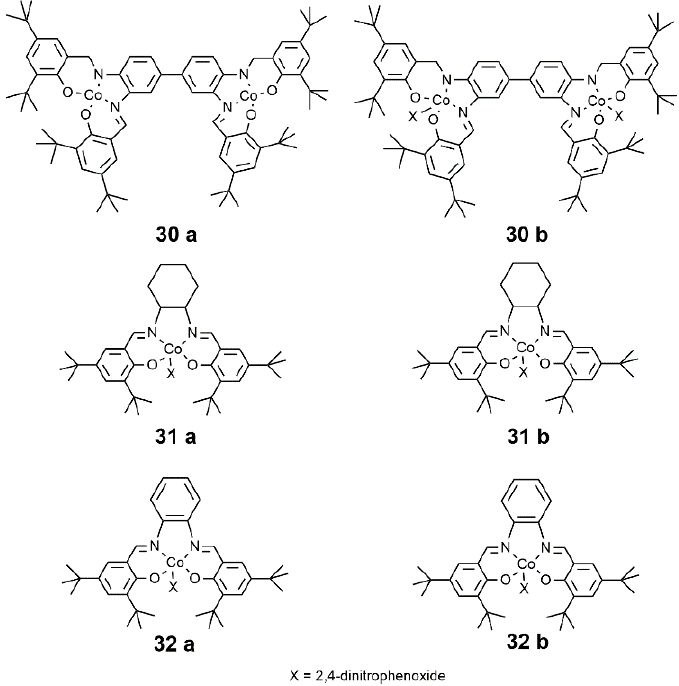
Figure 12. Structures of salenCo II complexes ( 30a – 32a ) and salenCo III complexes ( 30b – 32b ) [57]. Indeed, the Co(II) complexes ( 30a – 32a ) are active in the ROP of LA, and the Co(III) complexes ( 30b – 32b ), in combination with PPNCl, are active in the ROCOP of CO 2 with various epoxides (PO, CHO, SO). The terpolymerization was possible for the chain transfer between the two metal centers (Scheme 8).